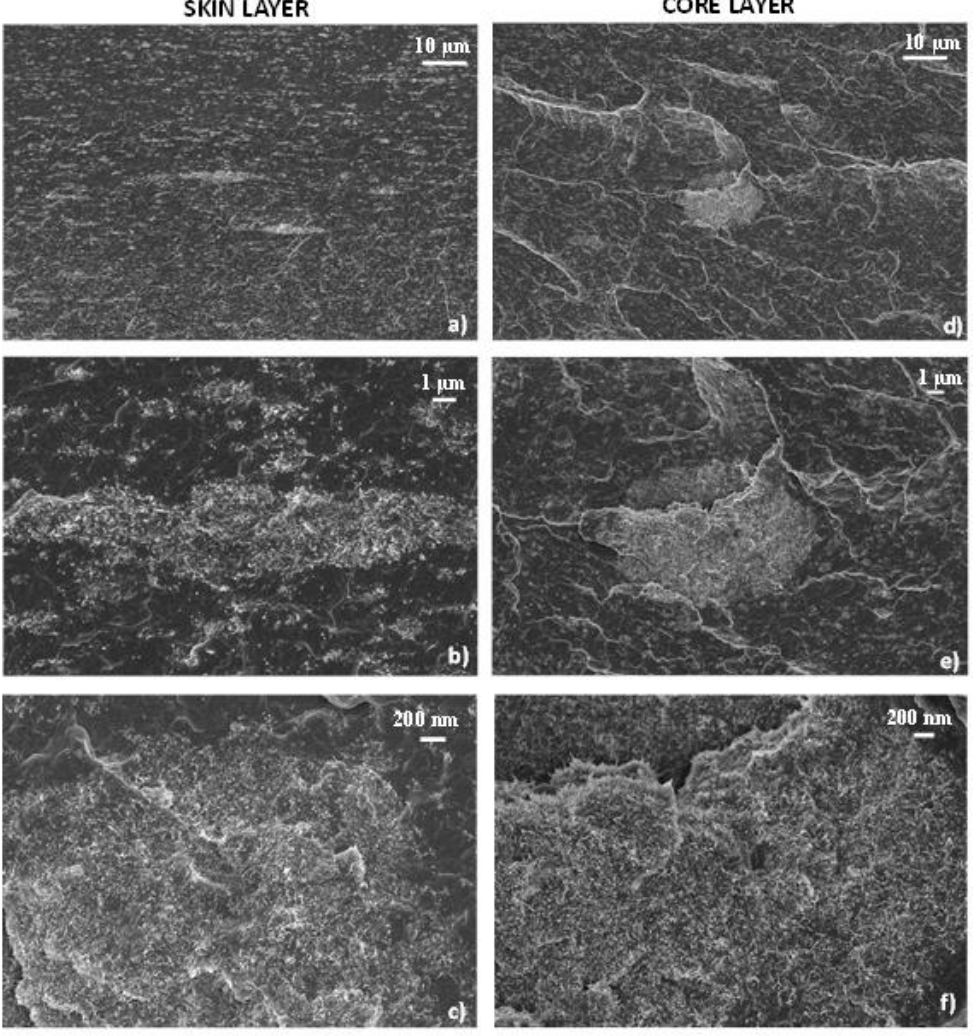
Figure 4. FESEM images of the cross-section of 3%-MWCNT nanocomposite. The micrographs were obtained at increasing magnifications from the skin layers ( a , b, c ) and from the core regions ( d , e, f ) respectively.